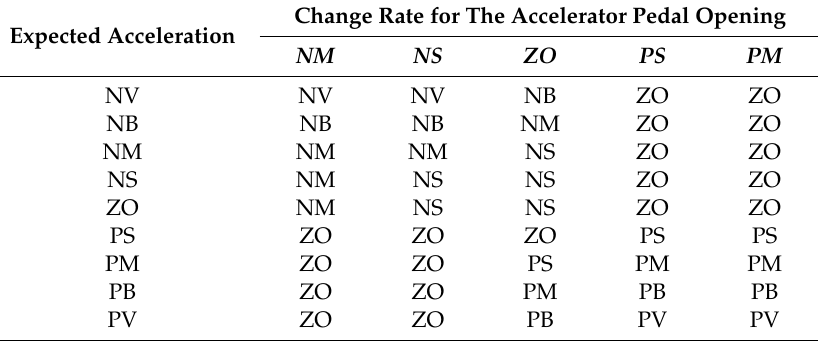
Table 1. The fuzzy rule